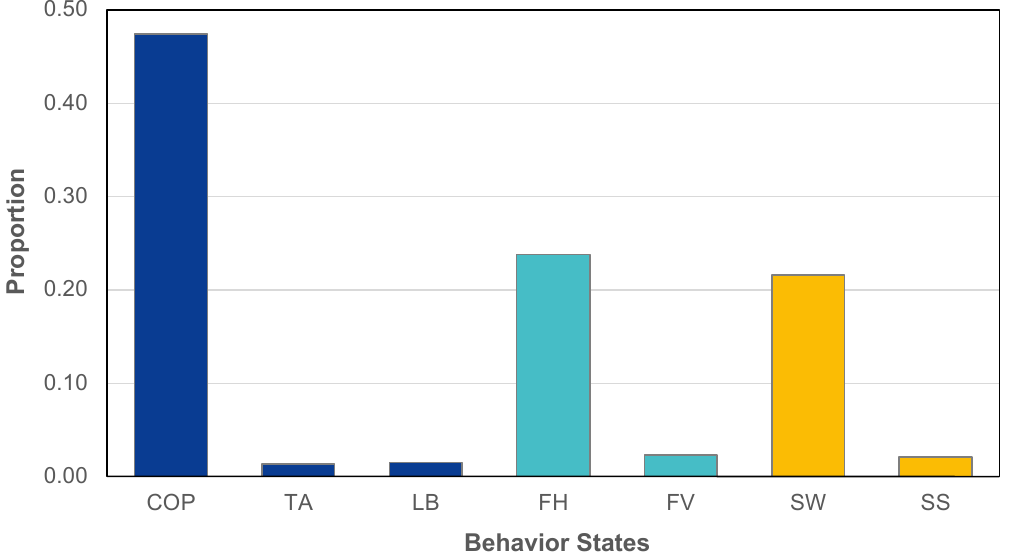
Figure 2. Proportion of intervals Ranger spent in each behavioral state overall. Colors represent larger behavior categories. COP = calm object play; TA = toy aggression; LB = linus blanket; FH = float horizontal; FV = float vertical; SW = swim; SS = speed swim.